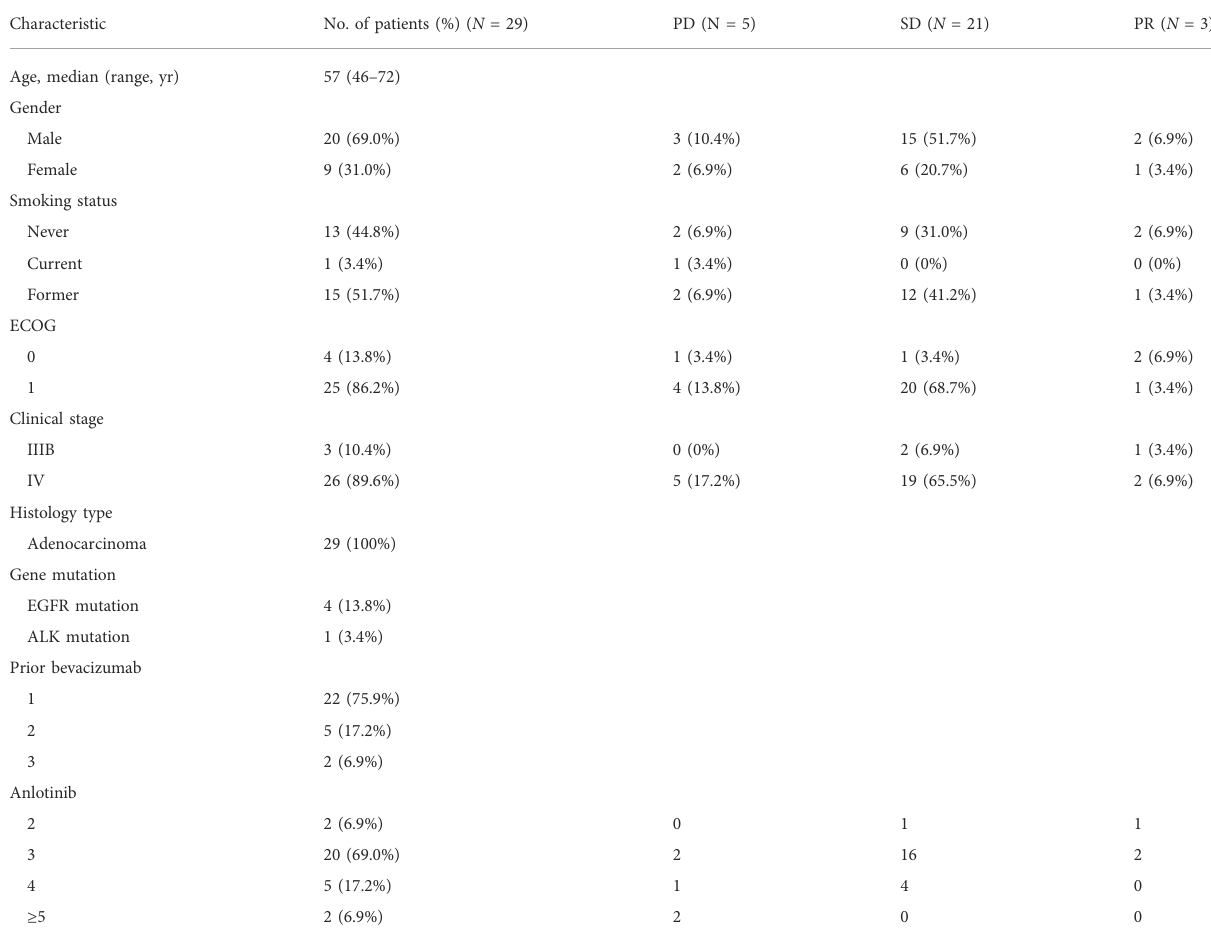
TABLE 1 Baseline demographics and disease